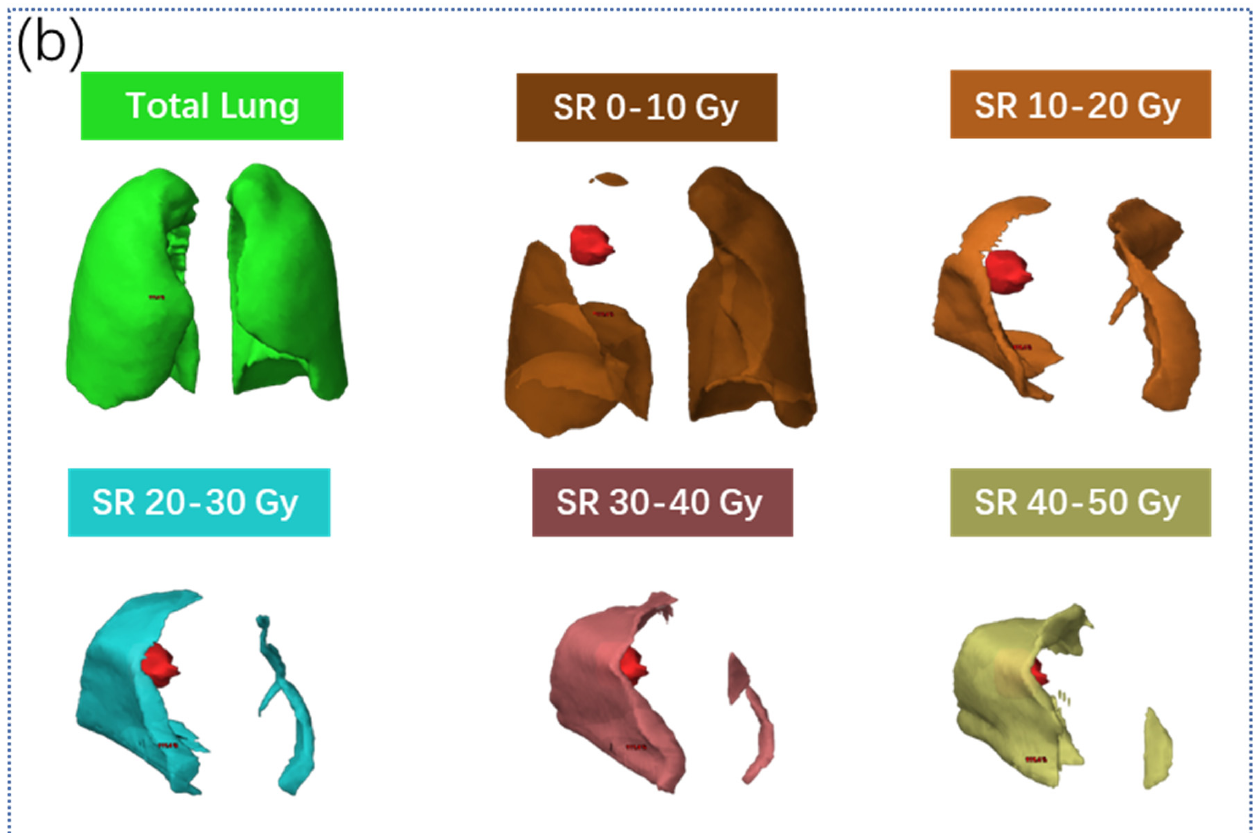
Figure 2. ( a ) An illustration lung subregion segmentation of 10–20 Gy. ( b ) The whole lung and the five lung subregions with dose intervals of 0–10 Gy, 20–30 Gy, 30–40 Gy, and 40–50 Gy of one example patient.